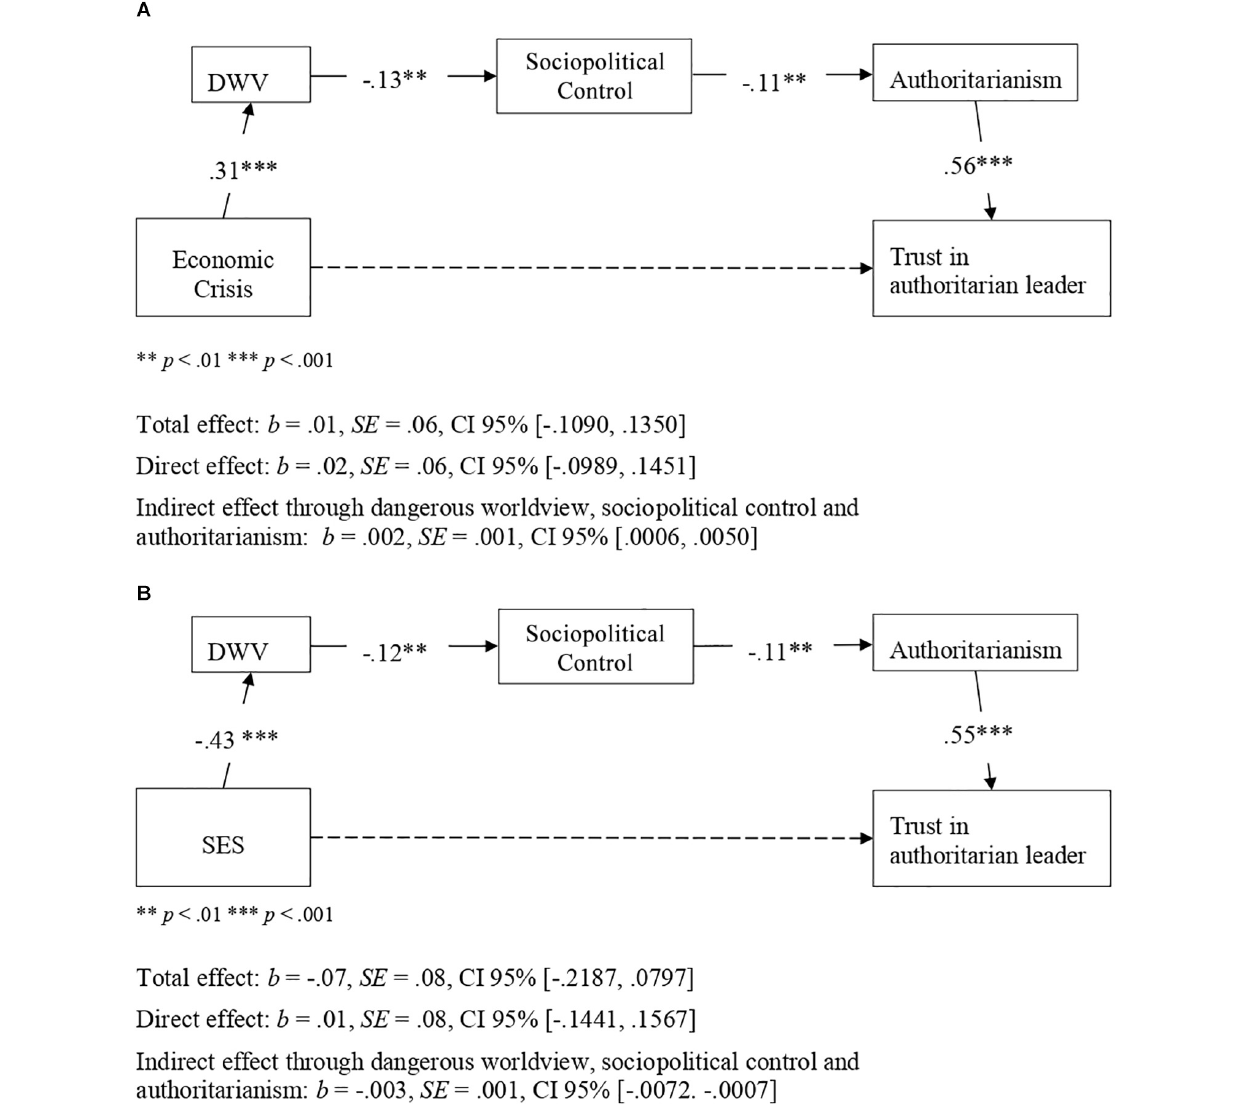
FIGURE 5 | Indirect effect of economic crisis (A) and participant’ SES (B) on trust in authoritarian leader through dangerous worldview, perceived sociopolitical control and authoritarianism. Unstandardized coefficients